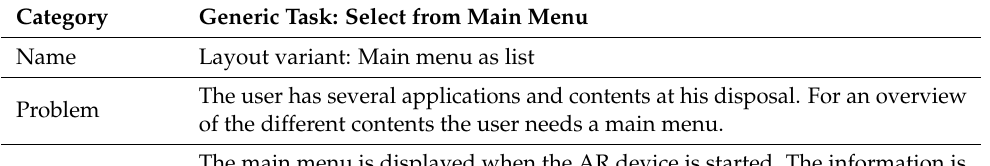
Table 11. Example of a pattern: Select from menu-list.